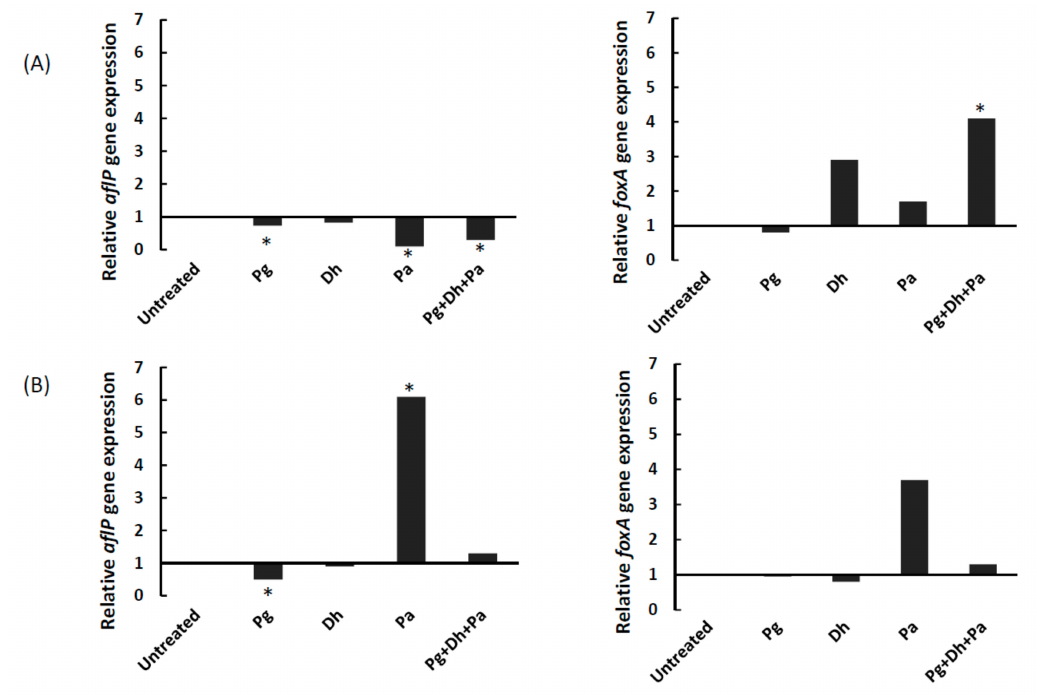
Figure 3. Effect of different combinations of biopreservative agents on relative gene expression of aflP (left) and foxA (right) genes in yeast extract sucrose broth ( A ) or calcium-enriched yeast extract sucrose broth ( B ) after five days. Pg: PgAFP; Dh: Debaryomyces hansenii ; Pa: Pediococcus acidilactici. *Means are significantly different from untreated batch ( p ≤